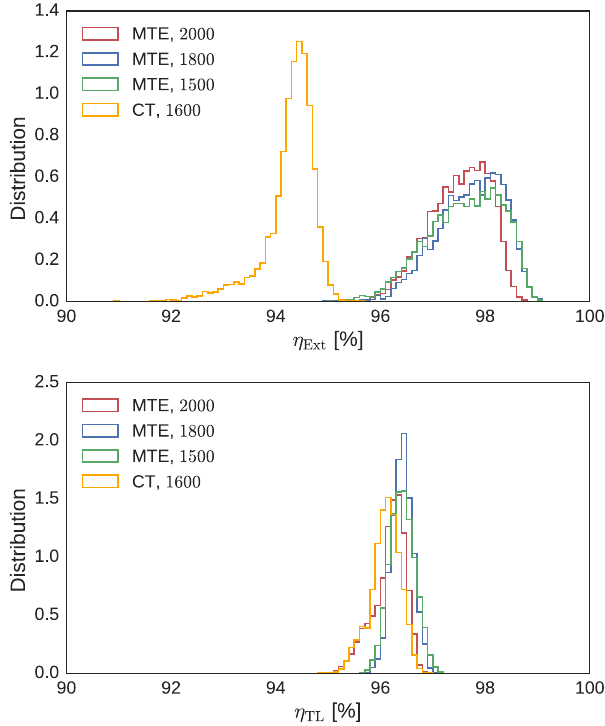
FIG. 13. Upper: Histogram showing the distribution of the PS extraction efficiency. Bottom: Histogram showing the distribu- tion of the transfer line transmission efficiency. The typical intensity values are in units of 10 10 ppp at extraction from the PS.